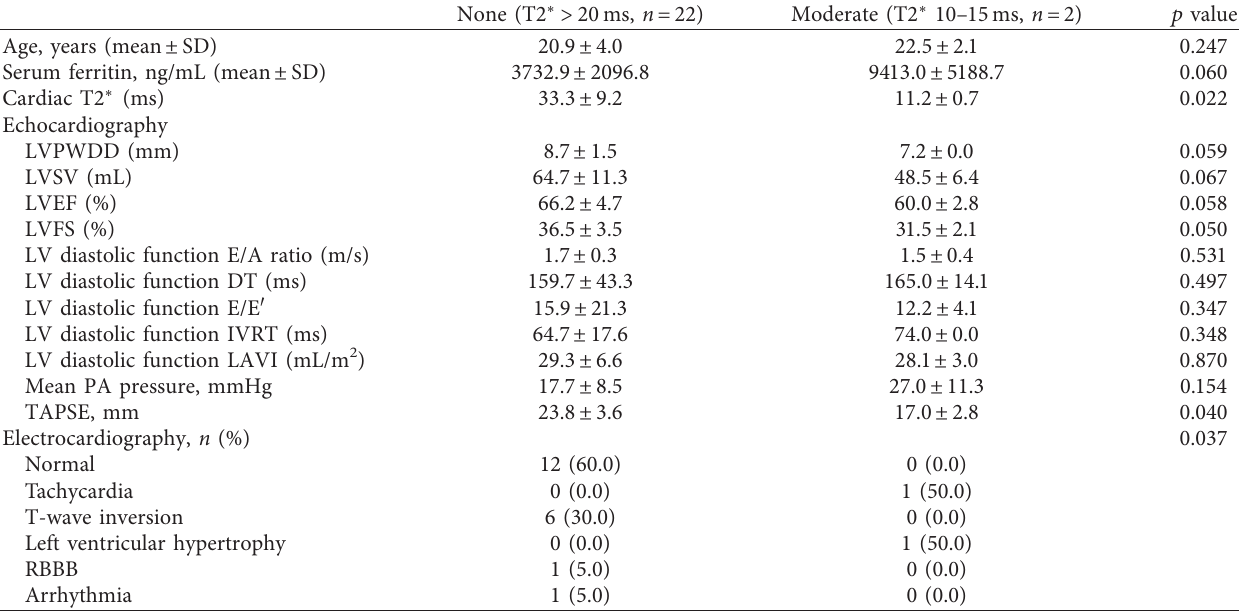
Table 4: Cardiac function stratified by presence of cardiac siderosis based on T2 ∗